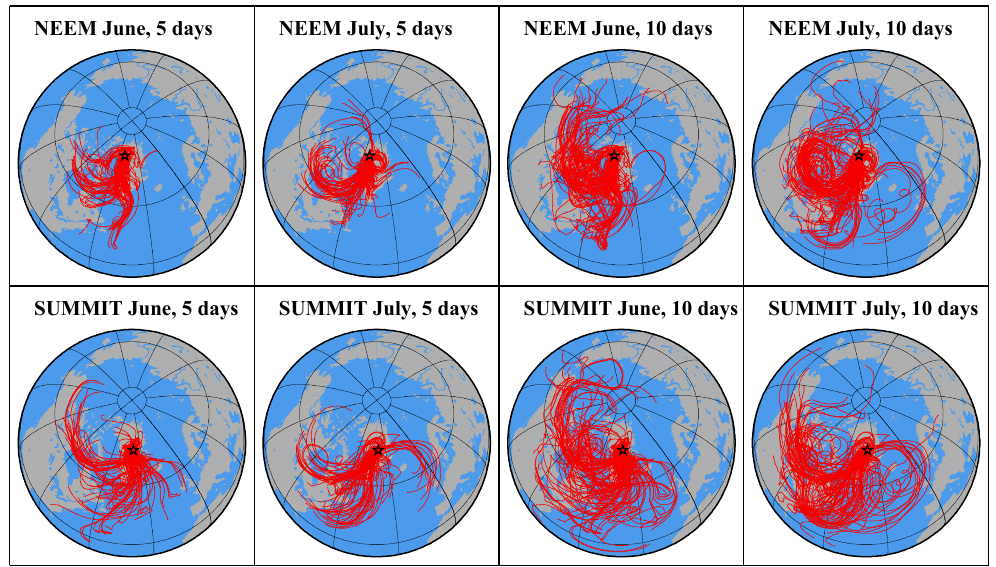
Figure 11. The 5- and 10-day backward air mass trajectories arriving at the NEEM and Summit sites in June and July 1978 (site arrival at 500m above ground